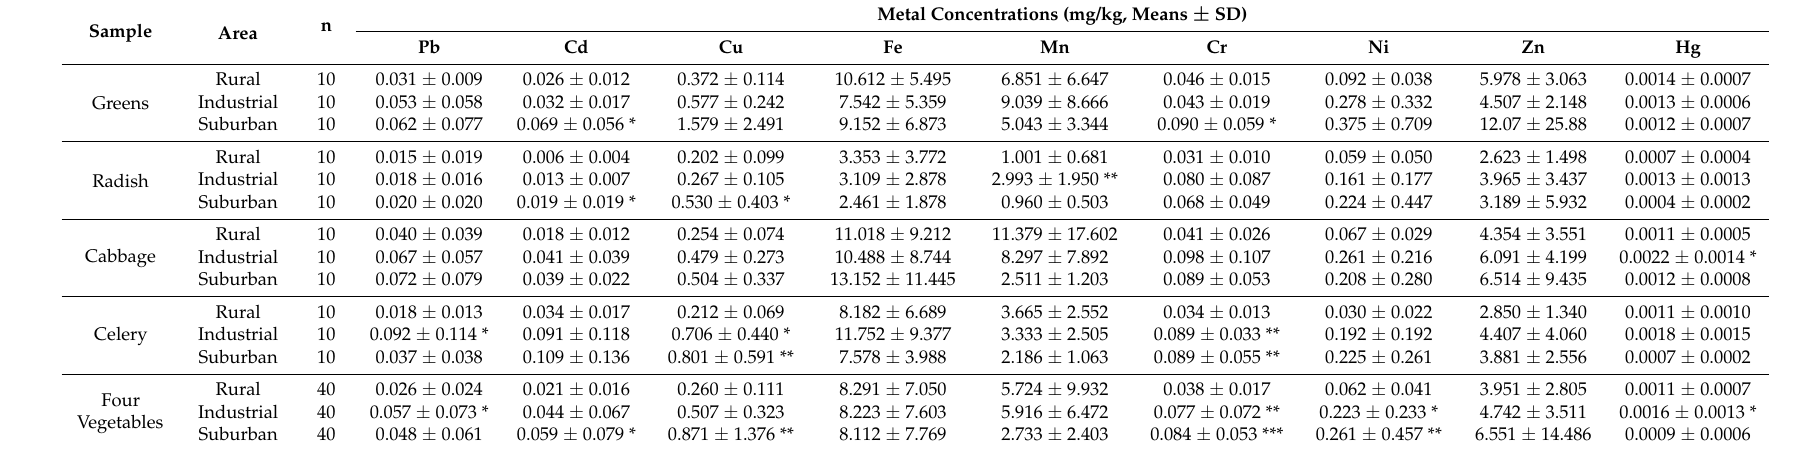
Table 2. Metal concentrations in different vegetables.